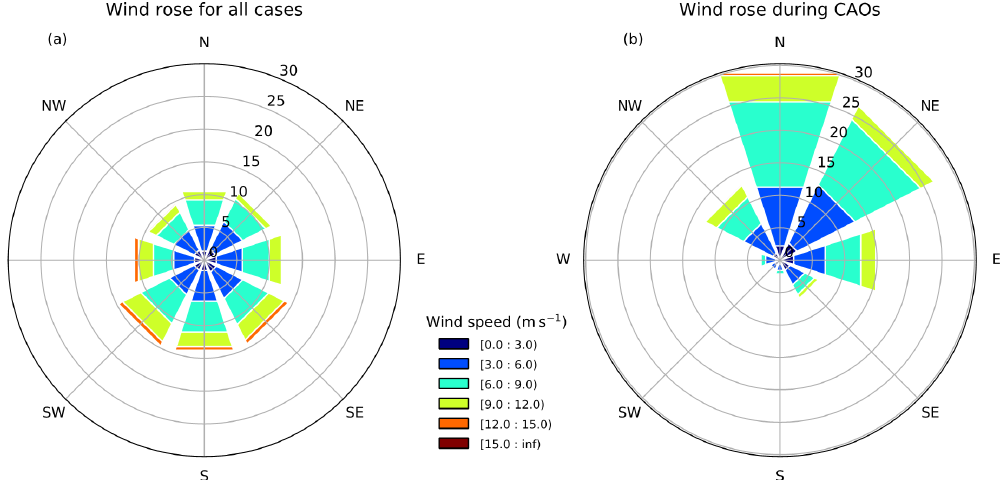
Figure 8. Frequency of occurrence of daily 10m wind speed and direction, averaged over the ice-free part of the Barents Sea for the November–April period from 1979 to 2018 for all cases (a) and for cold-air outbreaks (b) .